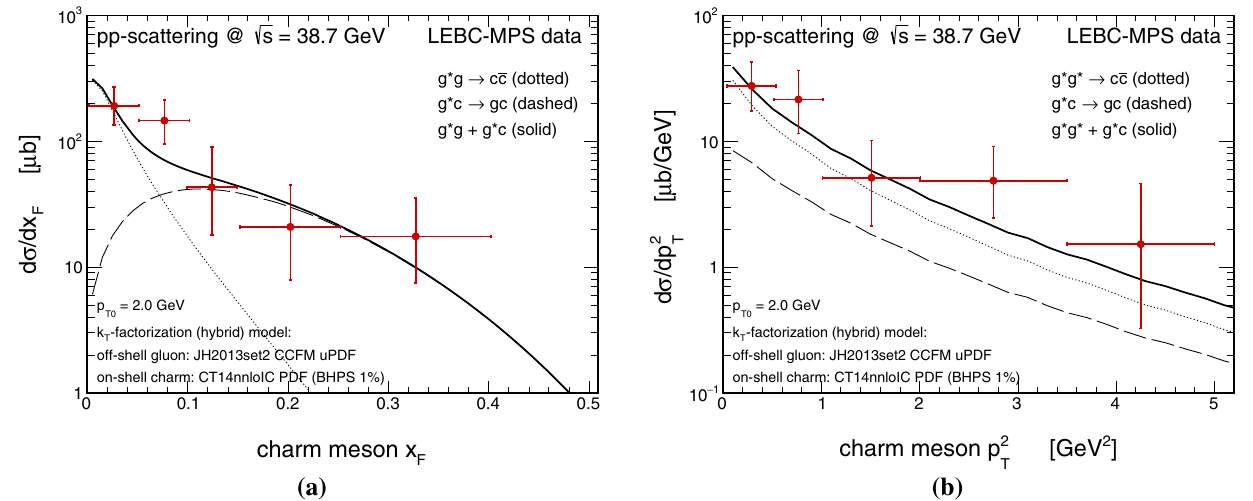
Fig. 5 Predictions of the hybrid model for a the Feynman x F and b the transverse momentum distributions of charm particles produced in pp √ s = 39 GeV. Presented here data are from Ref. [67] collisions at